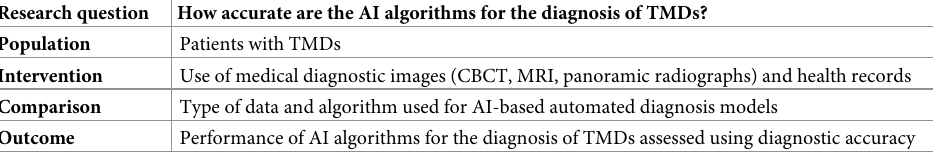
Table 1. Description of the population, intervention, comparison, and outcome elements. Research